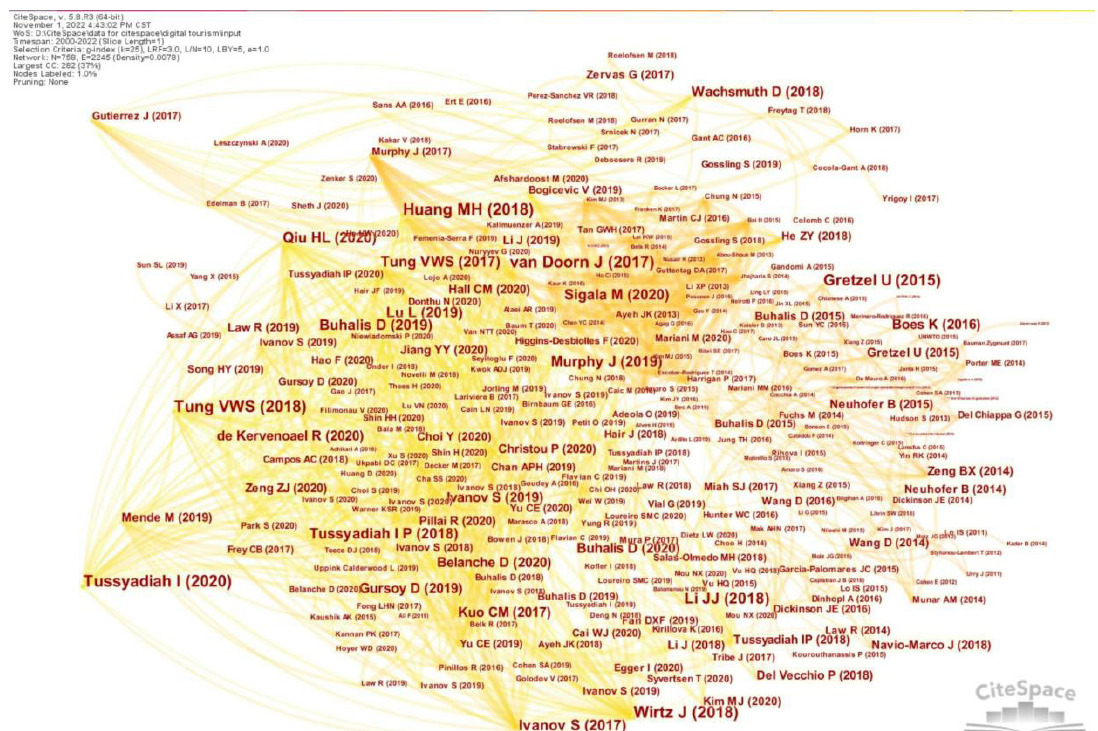
Figure 2. Knowledge map of author collaboration in digital tourism